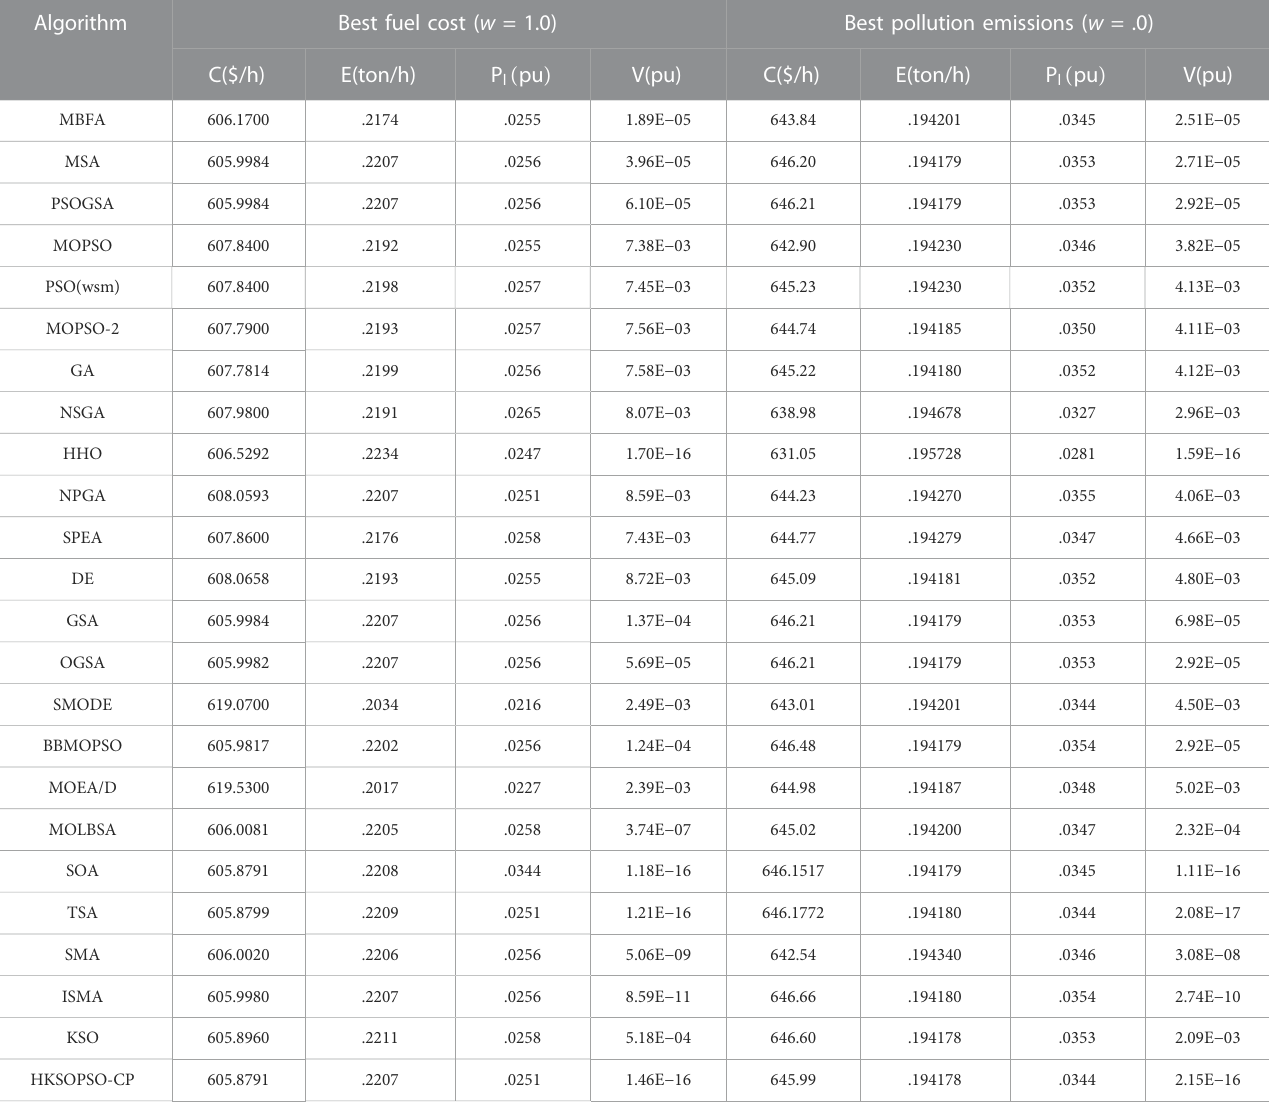
TABLE 6 Case 1 comparison between different algorithms optimizing for fuel cost or emission rate. Algorithm